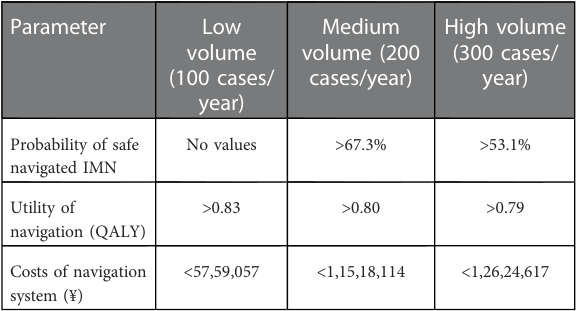
TABLE 3 Thresholds for parameters related to the cost-ef fi ciency of navigation in different volumes.